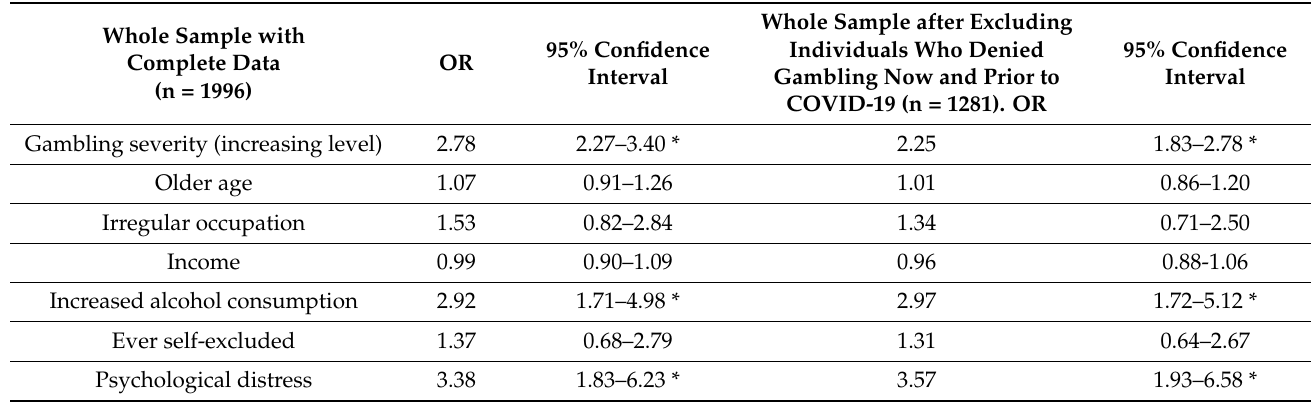
Table 4. Variables associated with self-reported increase in gambling. Logistic regressions, including all individuals with complete data (n = 1996), and all individuals after the exclusion of those reporting to be